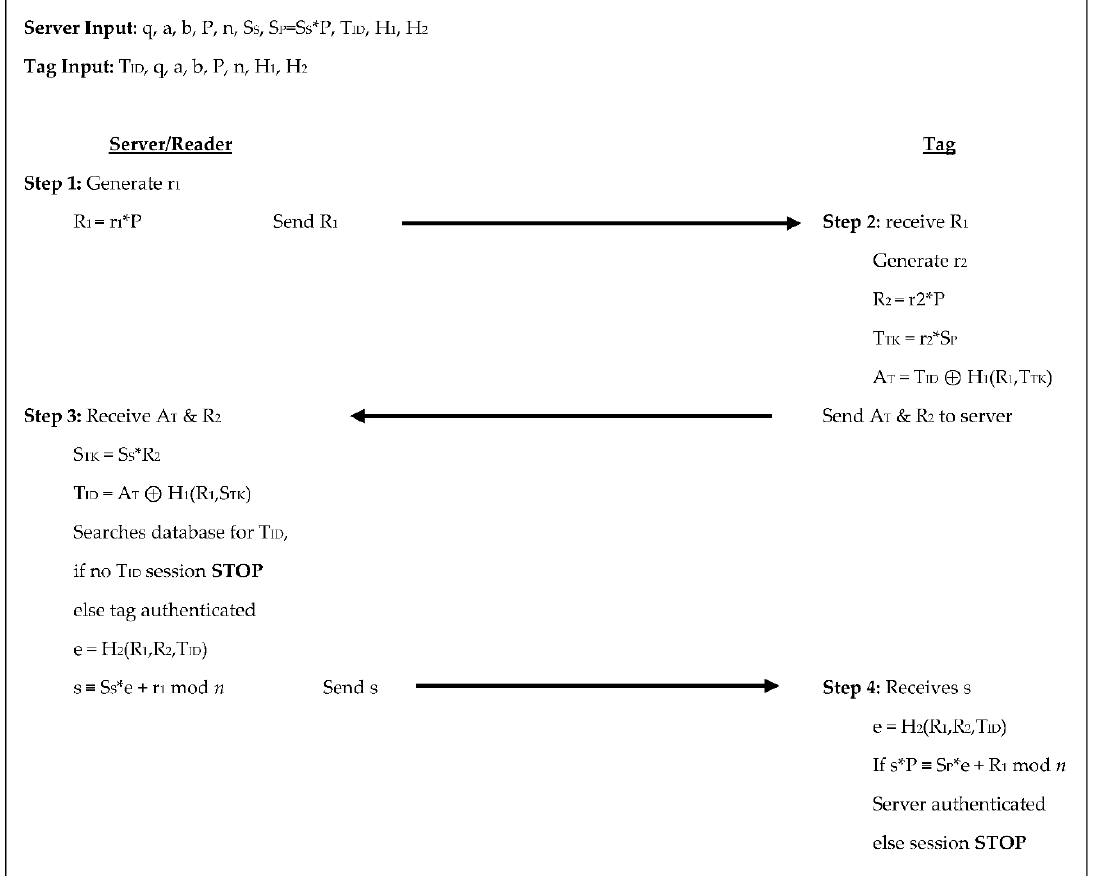
Figure 7. Authentication phases for Jin et al. [16].